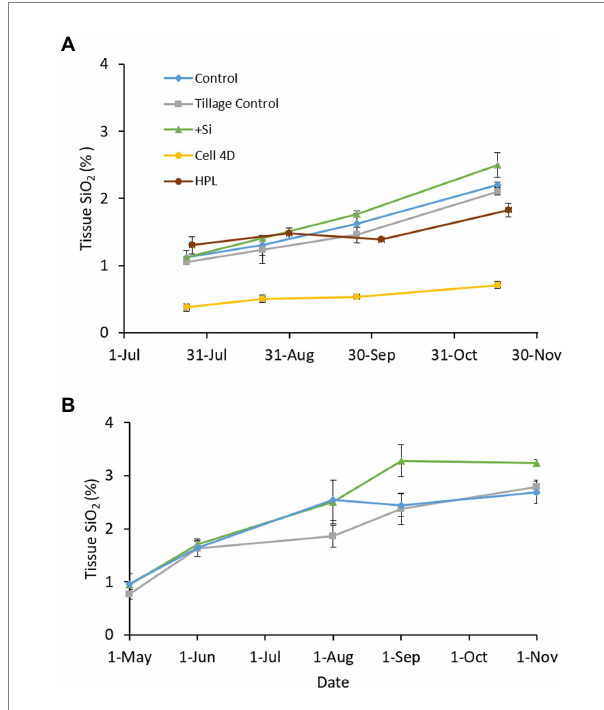
FIGURE 9 Mean (± standard error) Spartina alterniflora tissue SiO 2 concentrations in the Si amended and control plots through (A) 2012 and (B) 2013. Data from the reference marshes, Horn Point Laboratory (HPL) and Cell 4D, were excluded from statistical